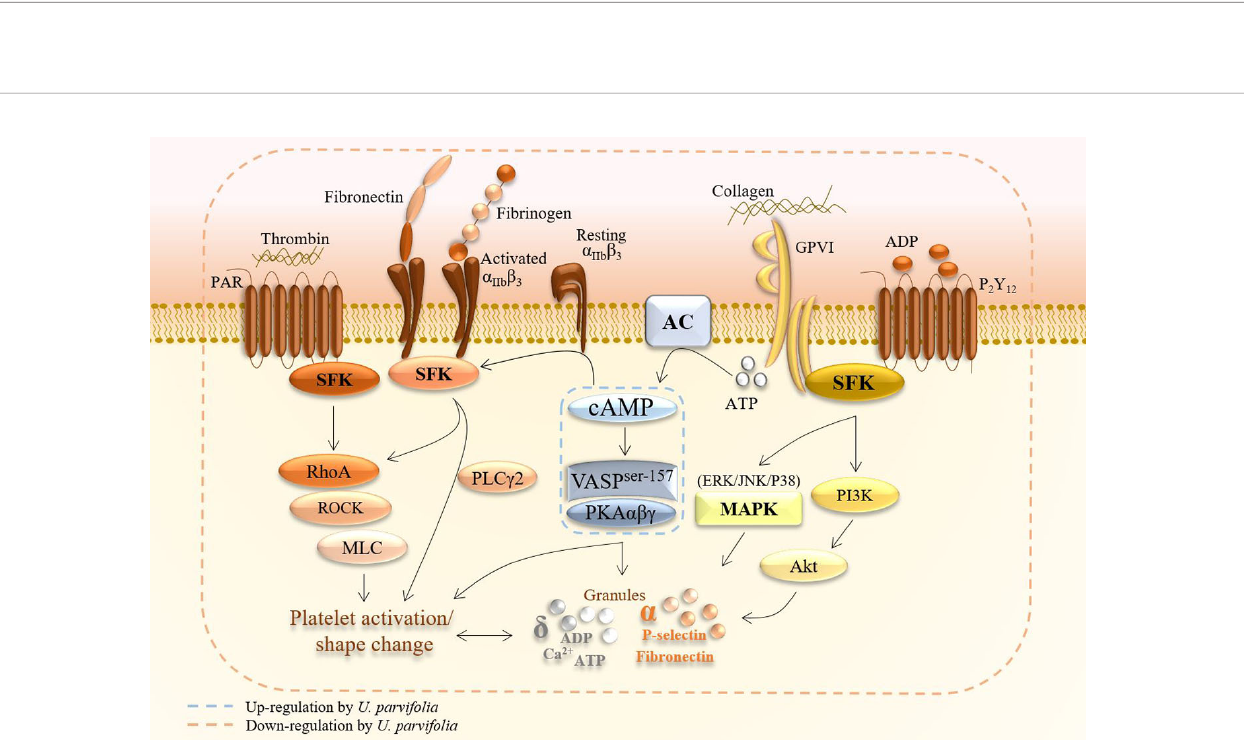
FIGURE 7 | Chemical constituents of U. parvifolia extract. (A) The UPLC chromatogram of EtOH extract of U. parvifolia was detected at 280 nm UV. (B, C) Chromatograms of a standard solution. Peaks 1 ((+)-catechin) and 2 (catechin-7-O- b -D-apiofuranoside).